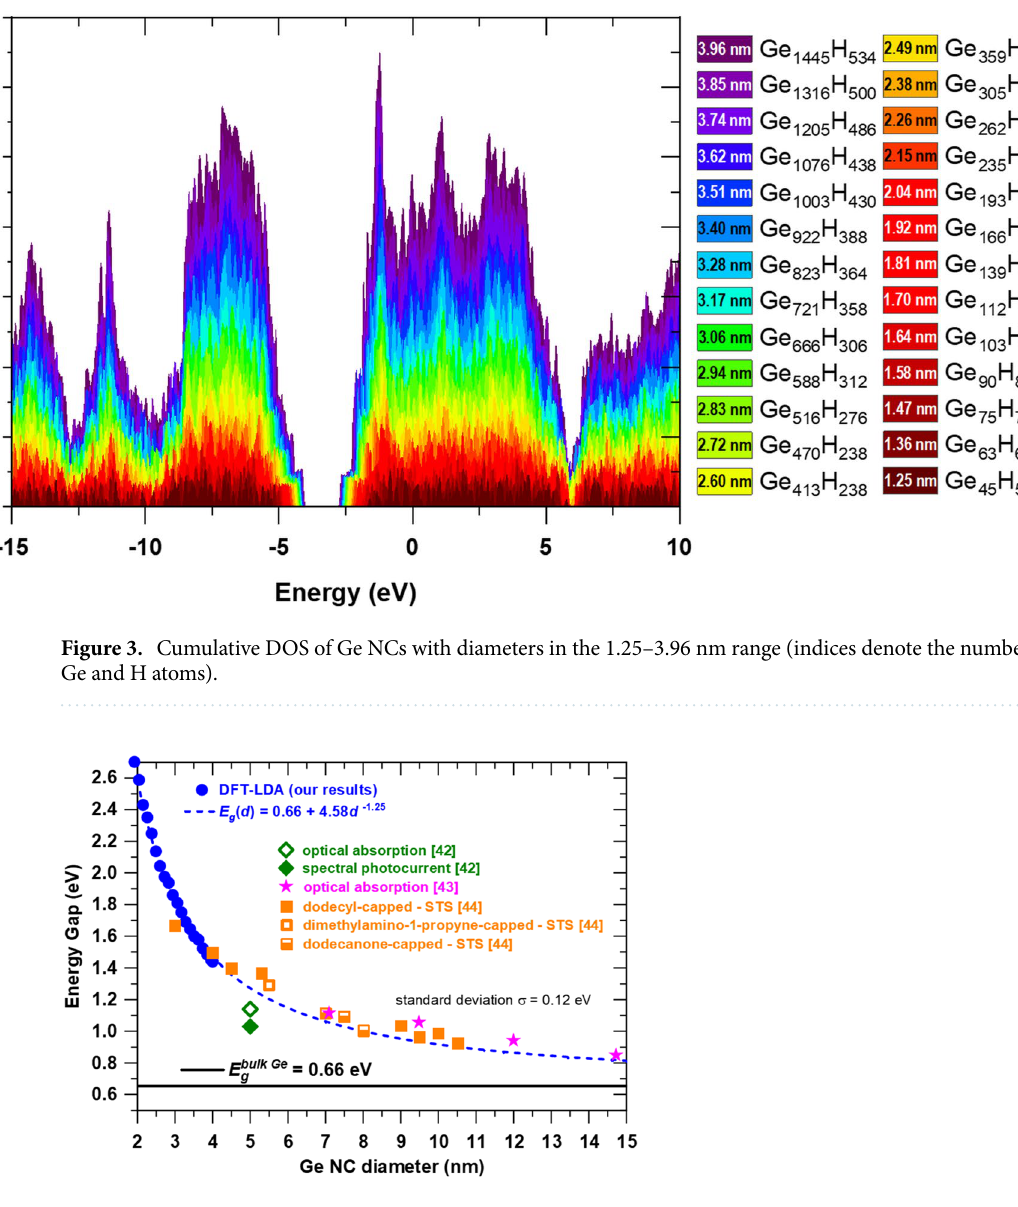
Figure 4. Ge NCs energy gap dependence on diameter: DFT calculations (filled blue circles for calculated points and dashed blue line for fit function in Eq. 1) and experimental data from optical absorption 42,43 , spectral photocurrent 42 and scanning tunneling spectroscopy (STS) 44 for which filled, empty and half-filled squares correspond to different capping